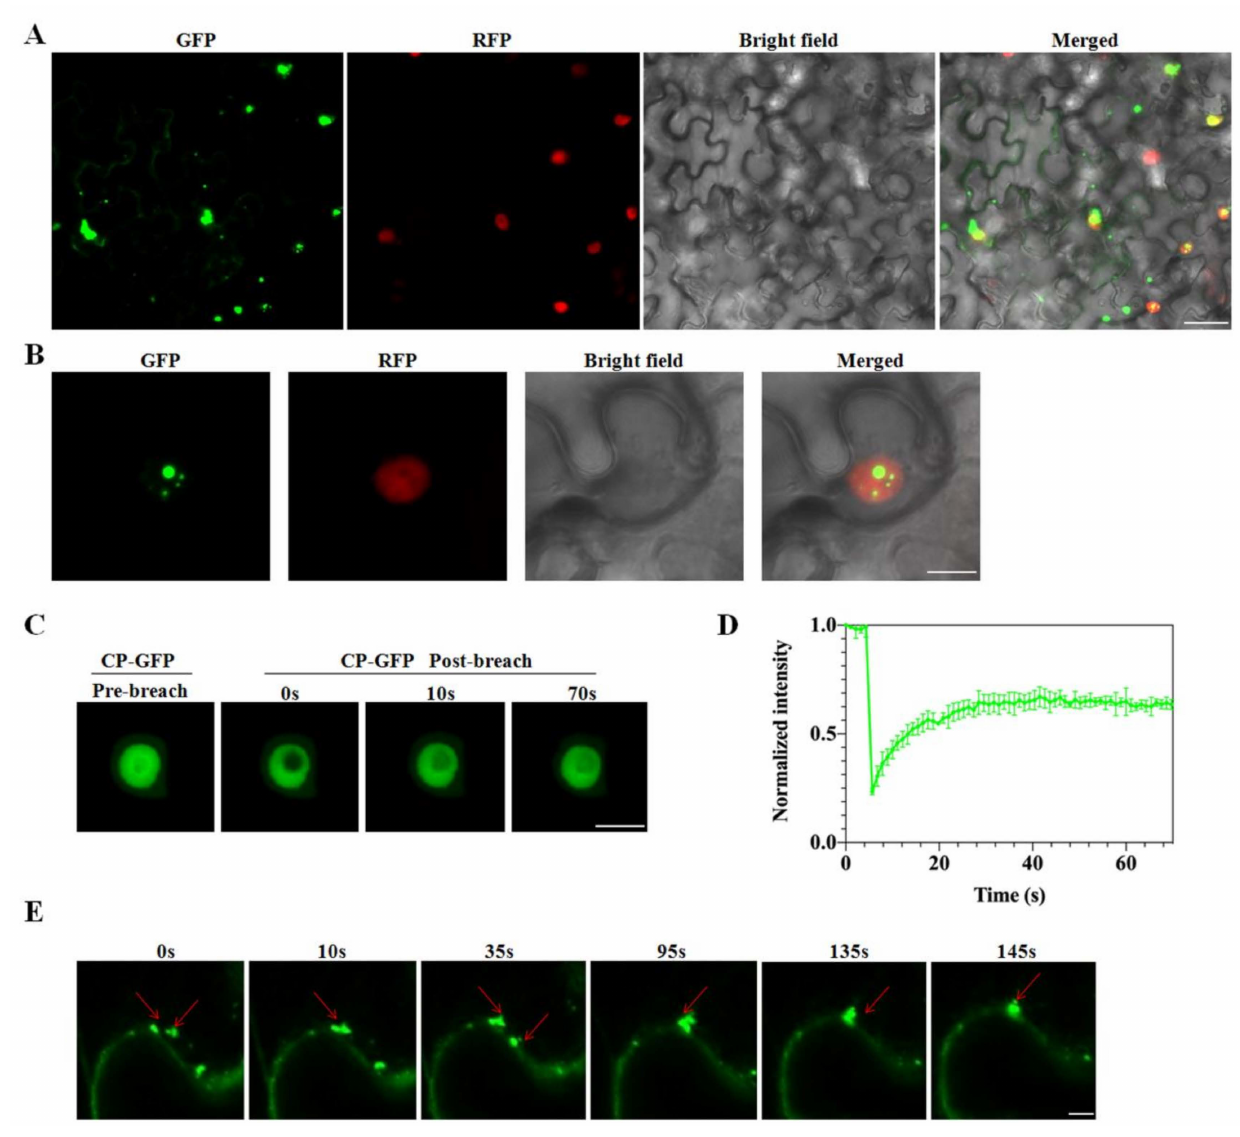
Figure 6. CVEV-DT1 CP protein forms liquid-like granules through liquid-liquid phase separation (LLPS) in vivo. ( A ) Subcellular localization of CVEV CP in H2B transgenic N. benthamiana leaves. Scale bars = 50 µ m. ( B ) Subcellular localization of CVEV CP in H2B transgenic N. benthamiana leaves. Scale bars = 5 µ m. ( C ) Representative image showing fluorescence recovery of CP-GFP granules after photobleaching (FRAP) in N. benthamiana leaf epidermal cells at 48 h. Scale bar = 5 µ m. ( D ) FRAP recovery curves of CP-GFP granules. The intensity of each granule was normalized according to its pre-bleached fluorescence. The data were presented as mean ± SD of 3 granules. ( E ) Confocal images showing dynamic fusion of CP-GFP granules in N. benthamiana leaf epidermal cells. Red arrows indicate fusion of CP-GFP granules. Scale bars = 50 µ